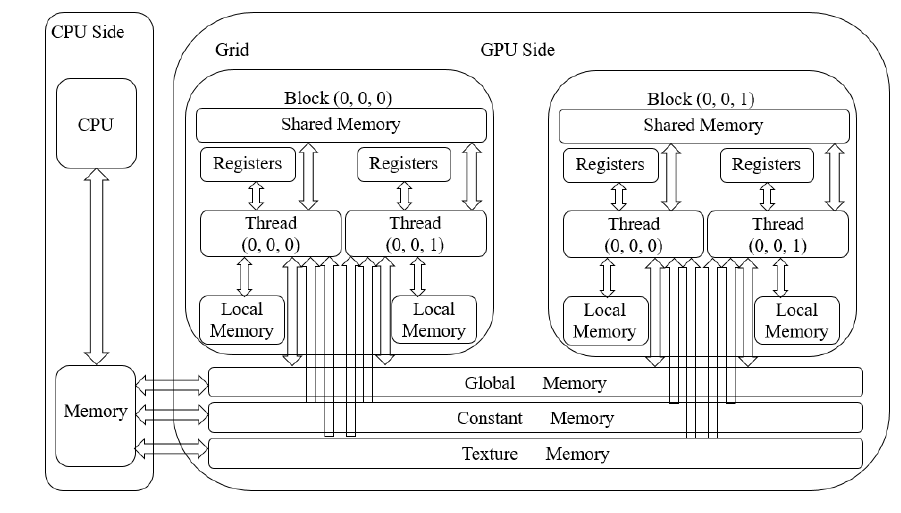
Figure 5. CUDA parallel computing model. Algorithm 1 The Steps of the GPU-PSO-Kriging Algorithm